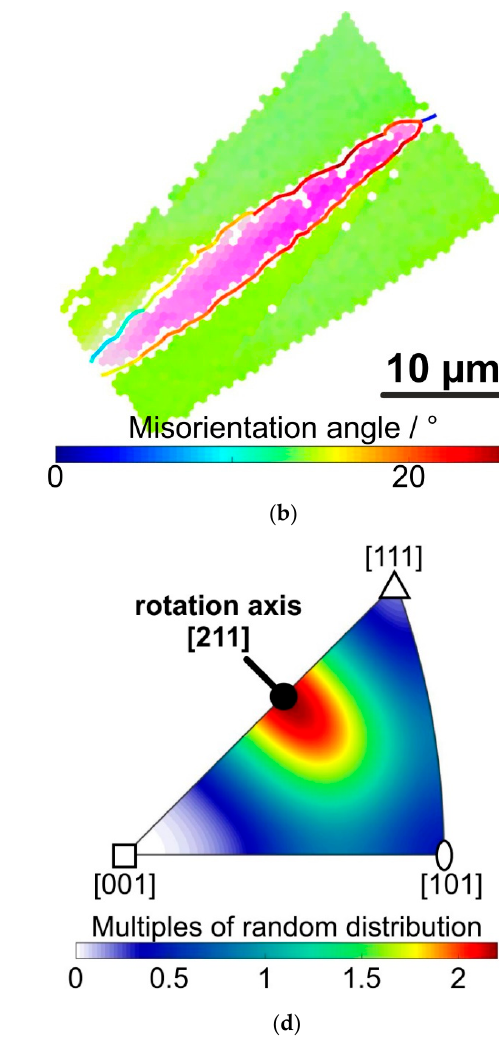
Figure 5. Properties of kink bands: ( a ) regions of interest (ROI) as an orientation map (top) with respect to CD (color code of orientations corresponds to the IPF of the inset) and kernel average misfit (KAM) map of the identical area (bottom). High angle grain boundaries are depicted as black lines. ( b ) Misorientation angle distribution along the boundary of one individual kink band highlighted by the red polygon in ( a ). ( c ) Relative frequency distribution of misorientation angles (histogram) from ( b ). Bin size is 2°. Bi-Gaussian fit is plotted as a line diagram. ( d ) Orientation distribution of rotation axes determined from the ROI of ( b ) presented as a color map in an IPF.